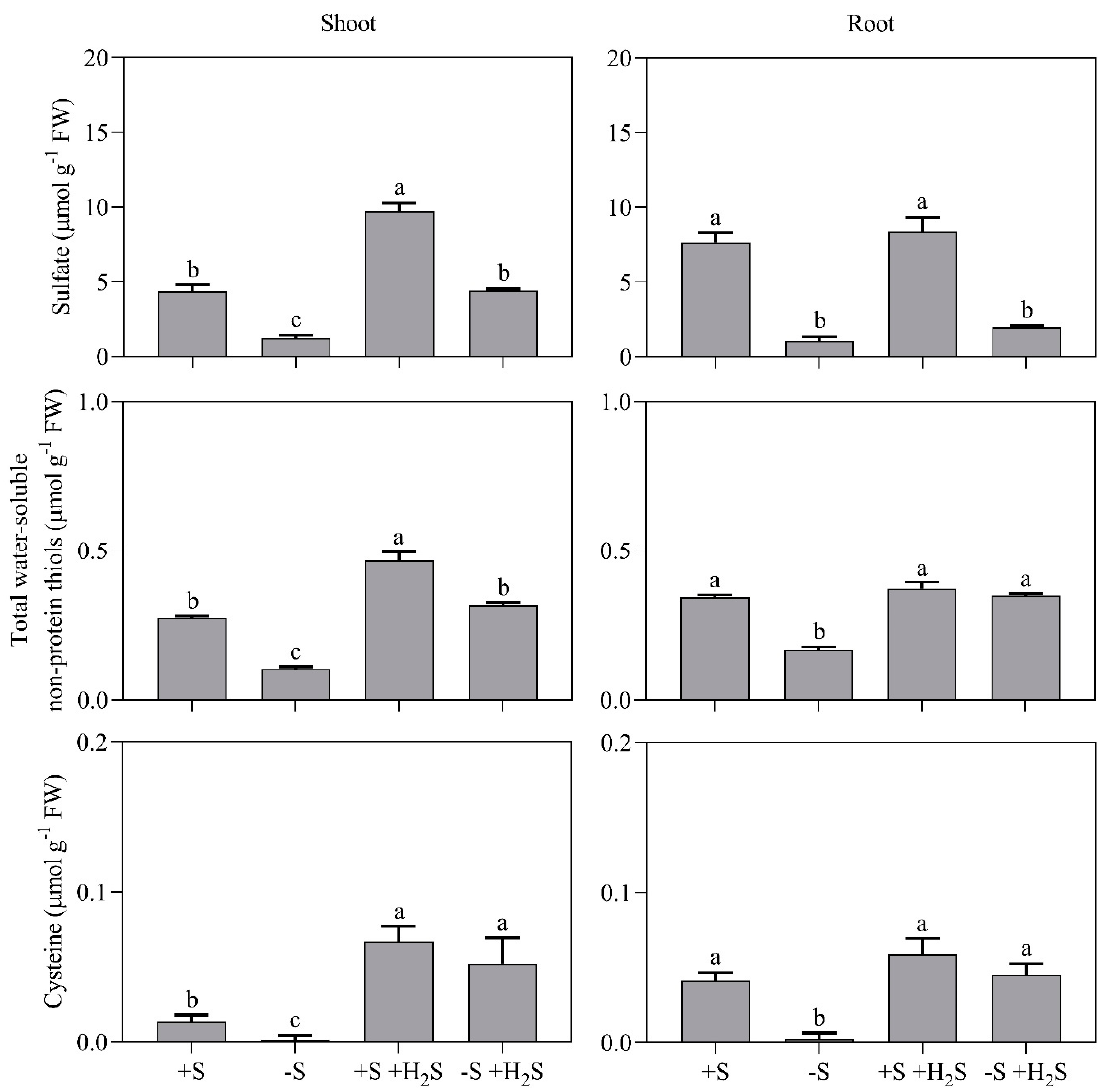
Figure 2. Sulfate, total water-soluble non-protein thiol and cysteine content of barley shoots and roots in the presence and absence of a H 2 S and sulfate supply. For experimental details, see the legend of Figure 1. Data represent the average of 3 measurements with 3 plants per measurement ( ± SD). Significant di ff erences between treatments are indicated with di ff erent letters ( P ≤ 0.05; two-way ANOVA; Tukey’s HSD test as a post-hoc test).